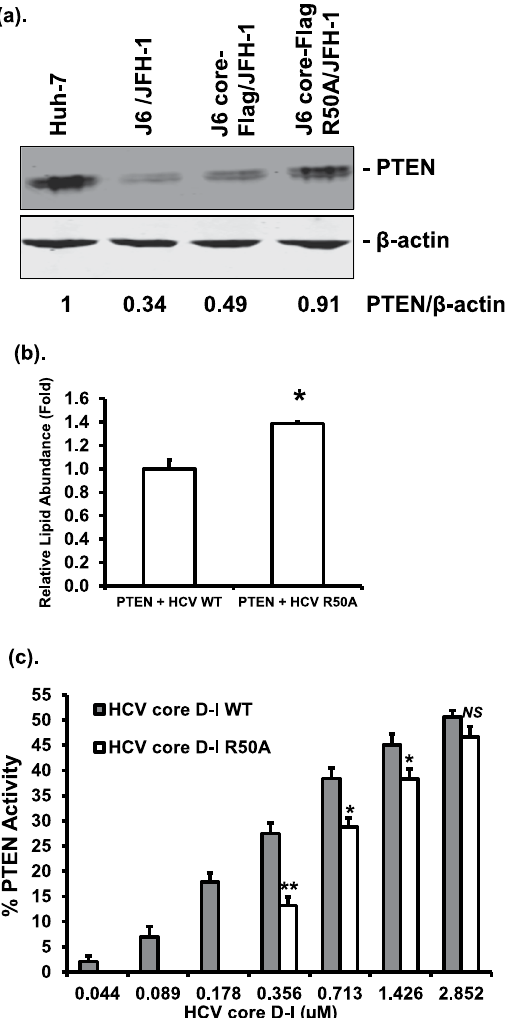
Figure 8. PTEN-HCV core interaction reduces PTEN levels, intracellular lipid abundance, and increases lipid phosphatase activity of PTEN. ( a ) The protein levels of PTEN in parental Huh-7 cells, Huh-7 cells harboring HCV-2a J6/JFH-1(p7-rLuc-2A), HCV-2a J6 core-Flag/JFH-1(p7-rLuc-2A) or HCV-2a J6 core-Flag R50A/JFH- 1(p7-rLuc-2A) were determined by Western blotting using anti-PTEN antibody. The levels of β -actin were also determined using anti- β -actin antibody. Relative PTEN band intensities against β -actin were given underneath each sample. This experiment was performed three times. ( b ) Huh-7 cells harboring HCV-2a J6/JFH-1(p7- rLuc-2A) (HCV WT) or HCV-2a J6 core-Flag R50A/JFH-1(p7-rLuc-2A) (HCV R50A) RNAs were transfected with a plasmid expressing PTEN. At 48 hours after transfection, cells were subjected to Oil Red O staining and neutral lipids were quantified. The statistical difference between samples was demonstrated as * if p ≤ 0.05. ( c ) Purified PTEN protein (20 nM) was incubated with increasing amounts of HCV core domain I (HCV core D-I) proteins, wild-type or R50A, as indicated. The phosphatase activity of PTEN towards PtdIns(3,4,5)P 3 was determined in the presence of increasing concentrations of the HCV core D-I proteins and presented relative to PTEN alone (set to a value of 1). The statistical differences between samples were demonstrated as * if p ≤ 0.05, ** if p ≤ 0.01, or NS for not significant. This experiment was performed three